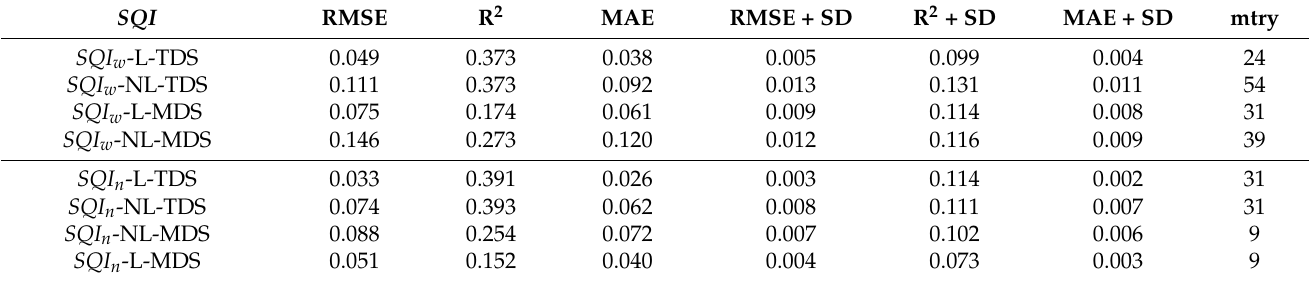
Table 8. Validation criteria of SQIs maps and random forest (RF) model result for SQI